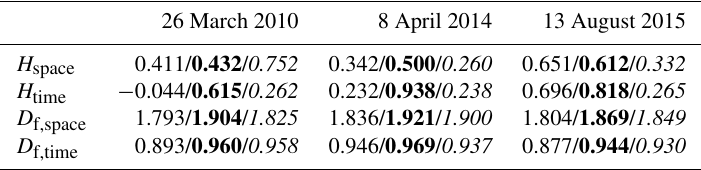
Table 4. Values of the non-conservation parameter H and the fractal dimension D f in time and space for all events for the radar QPE, the COSMO one-moment scheme (in bold font) and the COSMO two-moment scheme (in italic